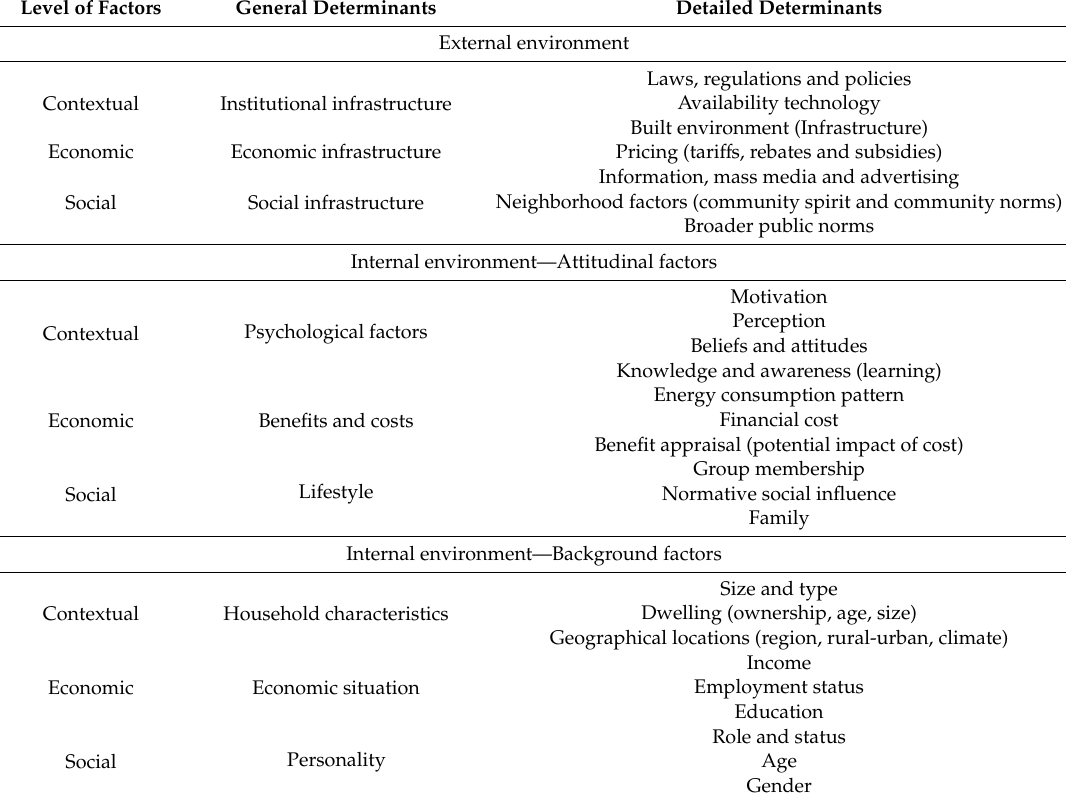
Table 4. Determinant of household energy